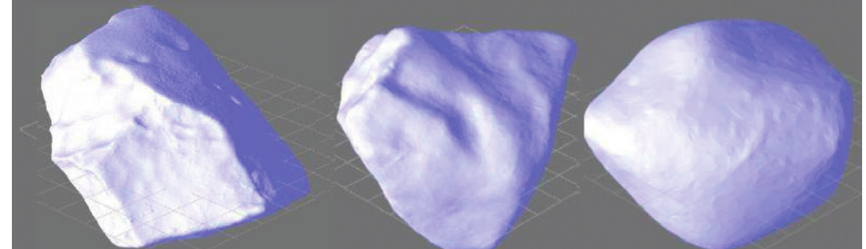
Figure 5: 3D models of meteorite Koˇsice. In the left is the model of uncatalogued fragment (2370g 135 × 105 × 100mm), in the middle is model with catalog no. 21 (208 g 70 × 63 × 36mm), and in the right is model with catalog no. 53 (23.2 g 28 × 22 × 21mm). The model sizes in the image are not